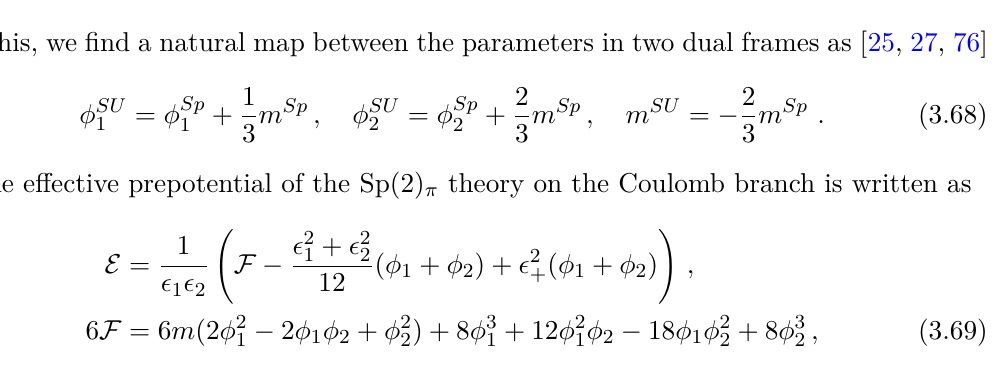
Table 5. BPS spectrum of SU(3) 4 for d i ≤ 3 . Here, d = ( d 1 , d 2 , d 3 ) labels the BPS states with charge d 1 e 2 + d 2 f 1 + d 3 f 2